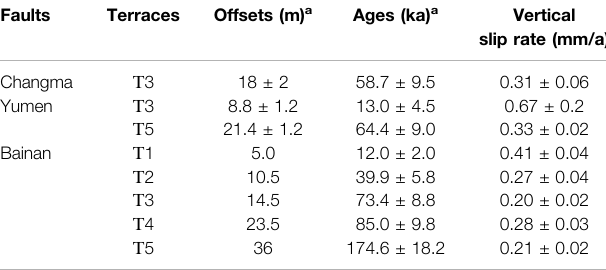
a TheageofterraceT1neartheBainanfaultfromHetzeletal.(2002)andotheroffsetand age data of terraces from our previous studies of Liu R. et al. (2017) and Chen and Koronovskii.